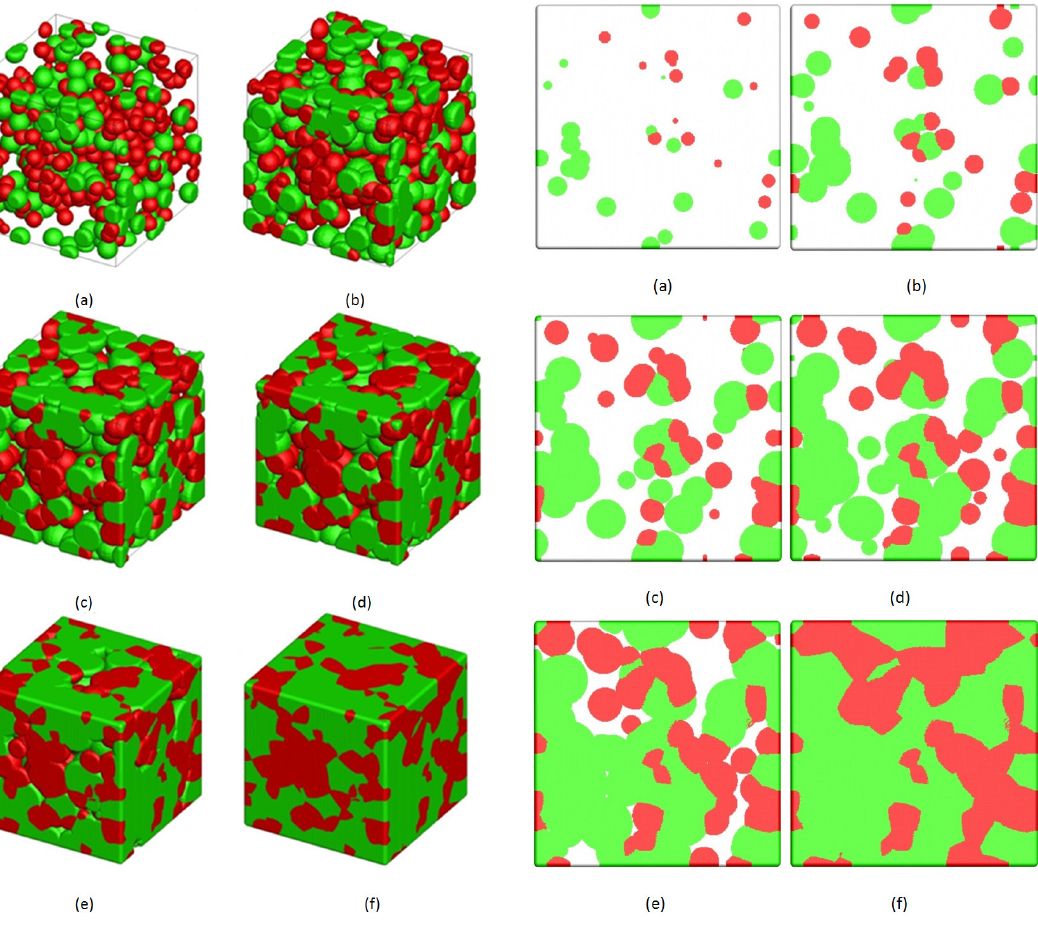
Figure 9. 3-d of the recrystallization: volume fraction of γ -fiber (“green”) and other (“red”) orientations are, respectively,: a)0.03, 0.02 b)0.12, 0.08 c)0.25, 0.15, d)0.36, 0.24, e)0.48, 0.32 and f)0.58, 0.42.